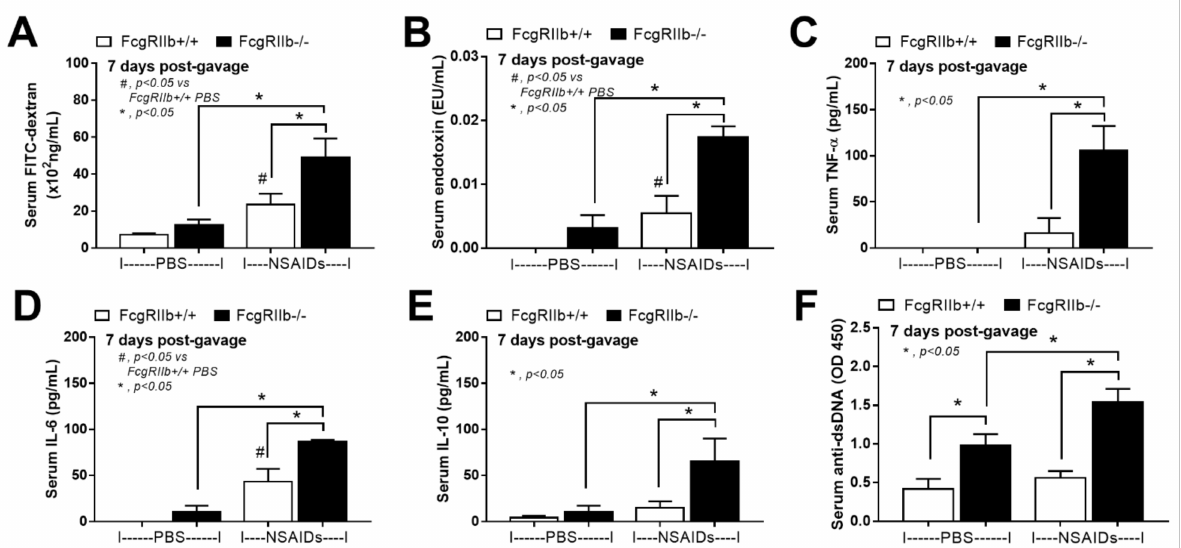
Figure 6. Characteristics of FcgRIIb-/- lupus mice and wild-type (FcgRIIb+/+) mice after the administration of indomethacin (NSAIDs) or phosphate buffer solution (PBS) control as determined by gut leakage (FITC-dextran assay) ( A ), endotoxemia ( B ), serum cytokines ( C–E ), and anti-dsDNA ( F ) ( n =